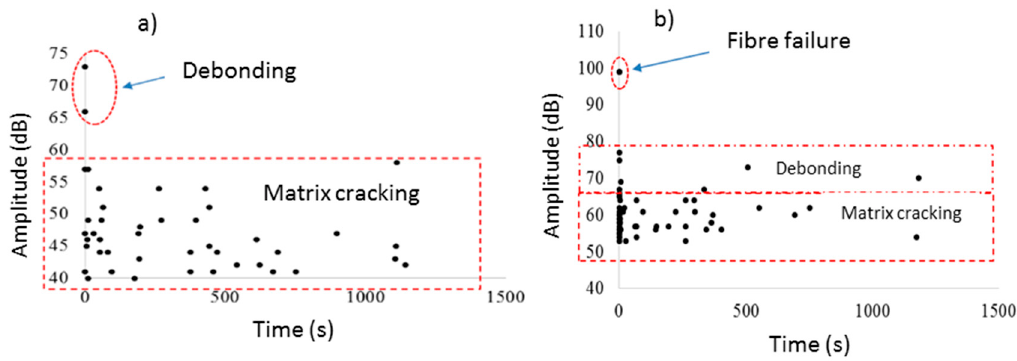
Figure 7. Amplitude versus time distribution of the AE signals for the fatigued samples: ( a ) virgin and ( b ) nano-interleaved.